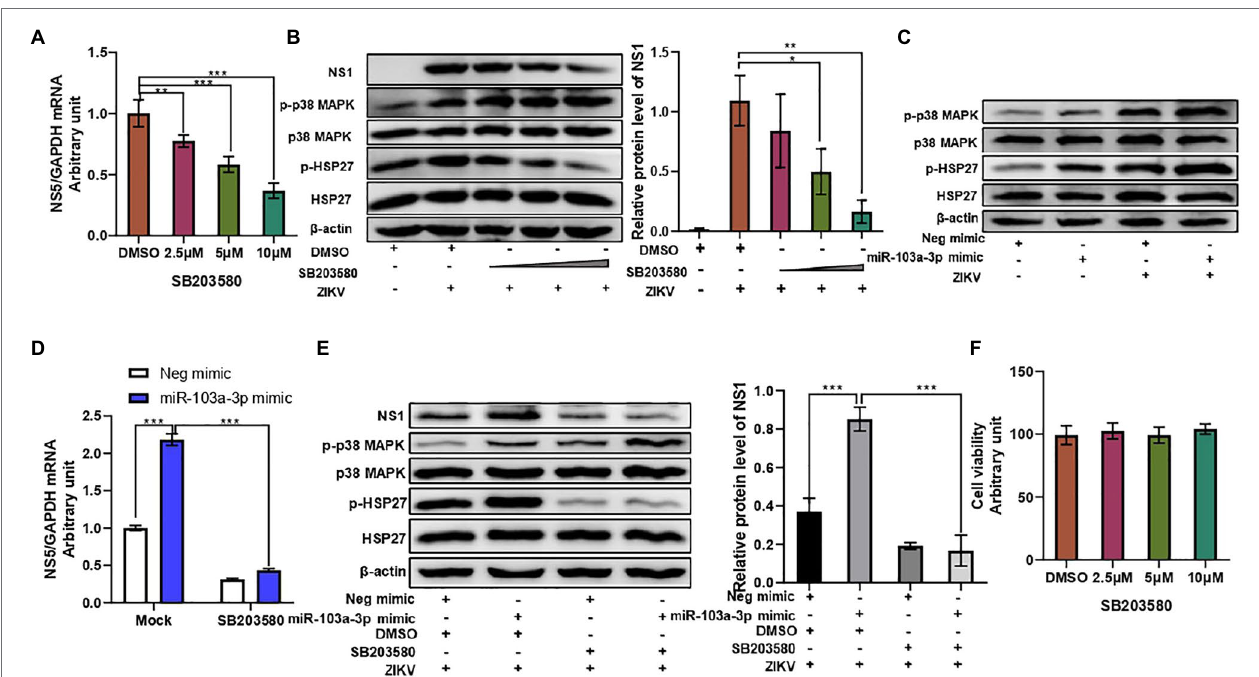
FIGURE 3 | miR-103a-3p stimulates ZIKV replication through activation of p38 MAPK signaling pathway. A549 cells were pretreated with SB203580 at indicated dose for 1 h or transfected with miR-103a-3p mimic or corresponding negative control and infected with ZIKV (MOI = 0.5) for 48 h. Total RNA and protein of cells were harvested at 48 h post infection for qRT-PCR or Western blot analysis. (A) SB203580 inhibits ZIKV RNA replication in a dose-dependent manner. (B) SB203580 inhibits ZIKV NS1 expression and p-HSP17 but increases p-p38 MAPK protein levels in a dose-dependent manner. (C) Over-expression of miR- 103a-3p increases p-p38 MAPK and p-HSP27 protein levels. (D) SB203580 treatment attenuates the stimulating effect of miR-103a-3p on ZIKV RNA replication. (E) SB203580 abrogates the stimulating effect of miR-103a-3p on ZIKV NS1 and p-HSP27, but not of p-p38 MAPK protein levels. (F) The selected dose of